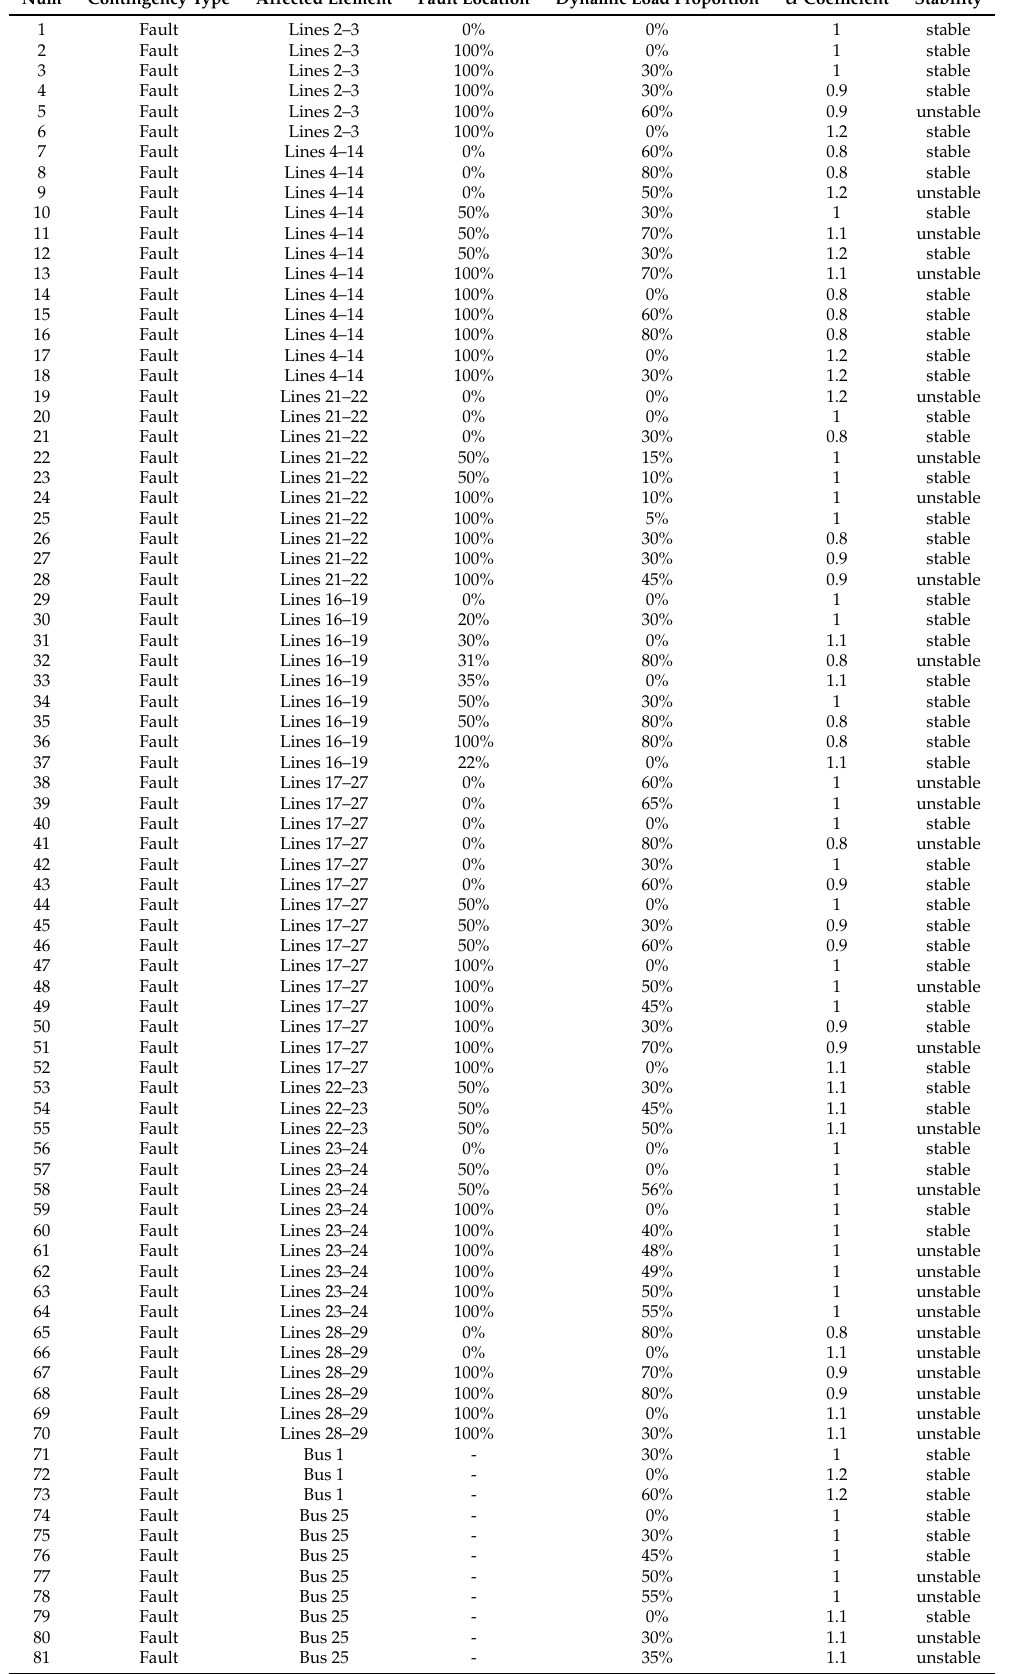
Table A1. Different conditions for creating SVS database using IEEE-39bus system